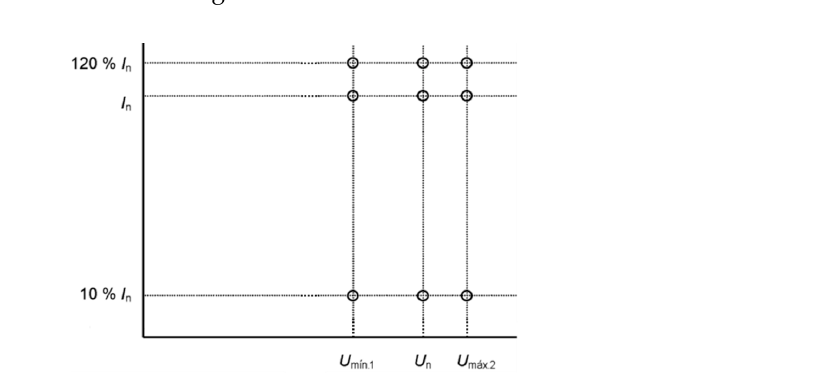
Figure 11. Calibration points for EMS without harmonics.